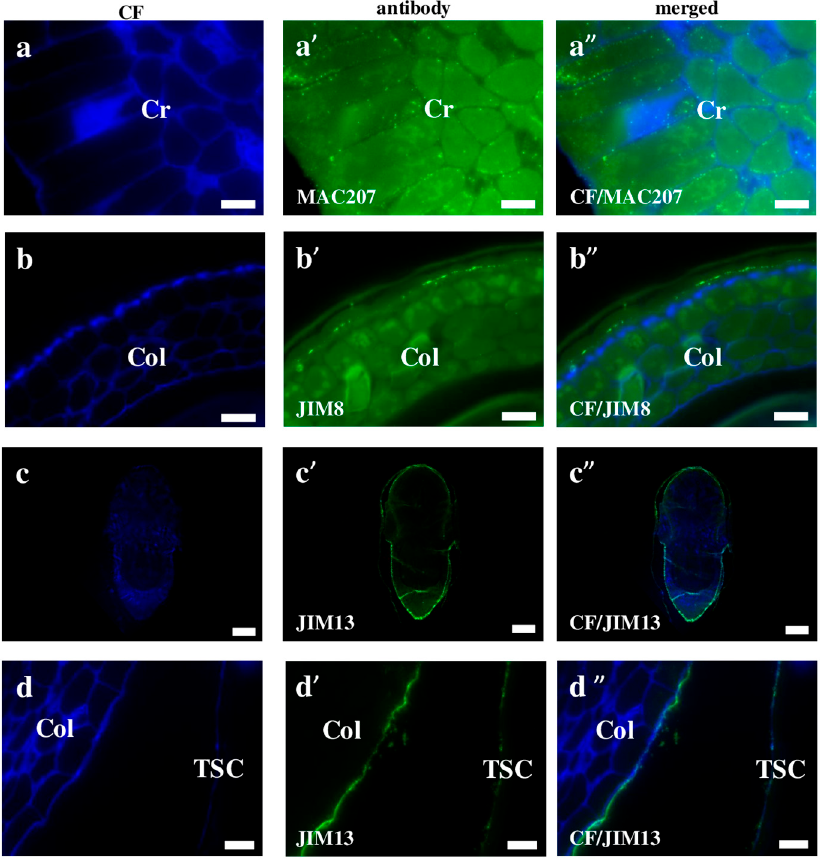
Figure 3. Immunolocalisation of arabinogalactan proteins in Brachypodium embryos. ( a – a” ) MAC207 in coleorhiza; ( b – b” ) JIM8 signal in coleoptile; ( c – c” , d – d” ) JIM13 in the entire embryo and the